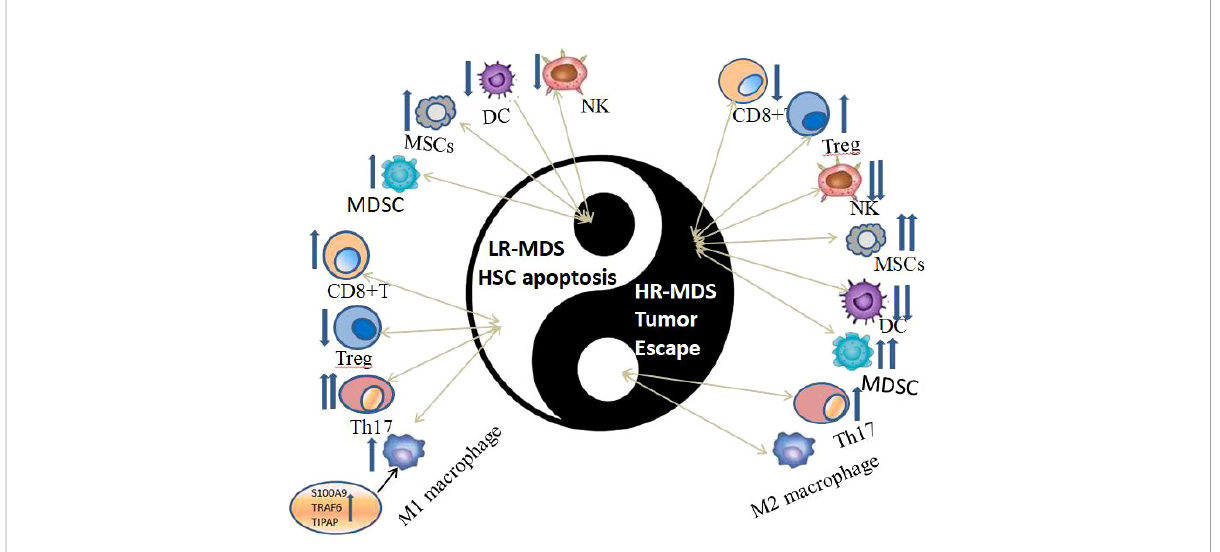
FIGURE 3 The immune dysregulation of immune cells in HR-MDS and LR-MDS can be summarized by an advanced philosophical thought “ Yin-Yang theory ” in ancient China, which are opposite, interrelated and can transform to each other under certain